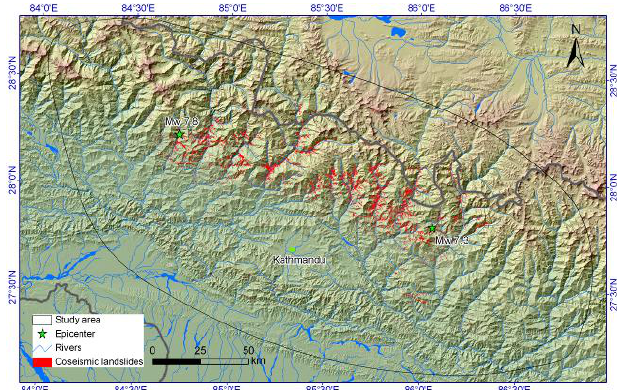
Figure 8. Spatial distribution of landslides triggered by the Gorkha earthquake